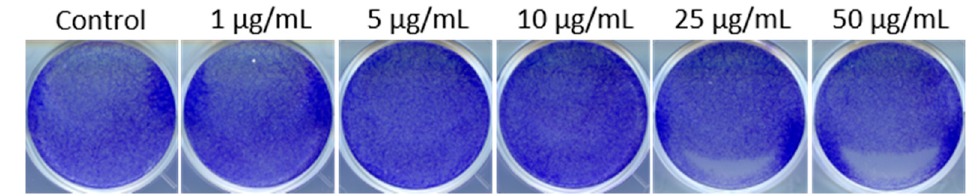
Figure 4. Colony growth assay of BT-12 (cultured in stem cell conditions) cells treated with 1–50 µg/mL of plain MSNs. MSNs without PEI functionalization do not show any cytotoxicity.